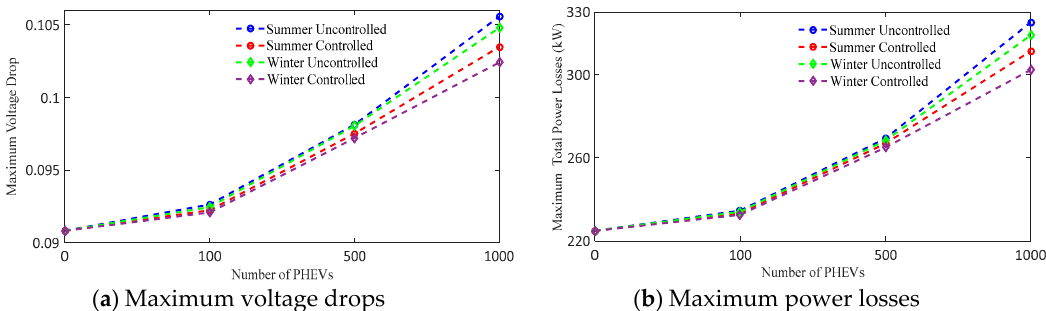
Figure 9. ( a ) Maximum voltage and ( b ) Maximum total power losses for controlled and uncontrolled charging using stochastic approach.